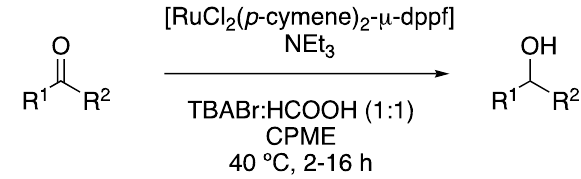
Figure 8. Ru-catalyzed transfer hydrogenation. Table 1. Selected examples of RedOx processes catalyzed by transition metals in DESs.